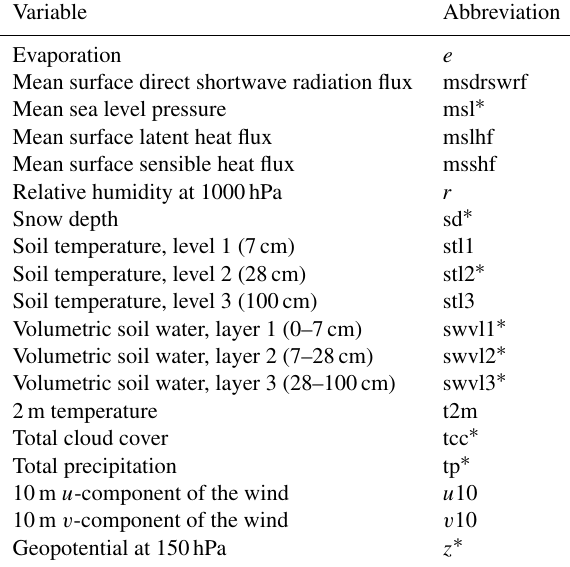
Table 1. Gridded parameters from the ERA5 reanalysis product. Asterisks ( ∗ ) indicate parameters which were found to be redun- dant – containing irrelevant or superfluous information compared to other parameters – and for this reason they were excluded from the final fitting of the